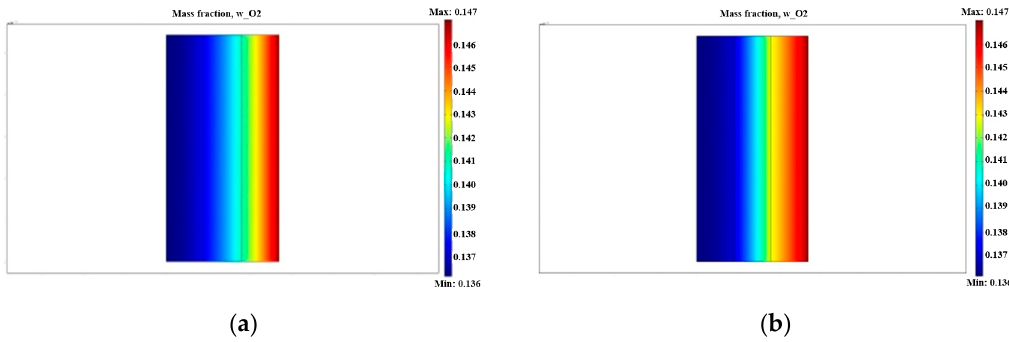
Figure 3. Comparison of oxygen mass fraction in the traditional catalyst layer and trilaminar-catalytic layer: ( a ) traditional catalyst layer; ( b ) trilaminar-catalytic layer.